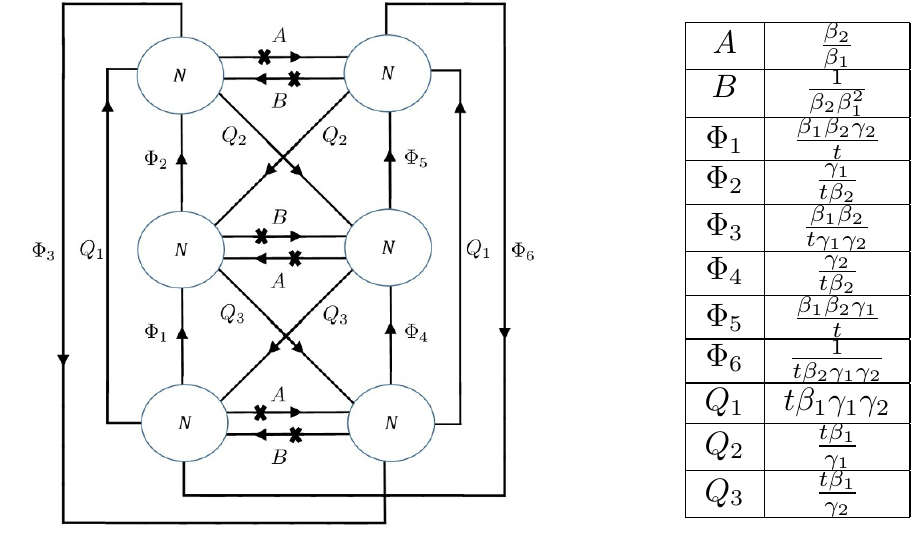
Figure 6 . On the left is the quiver diagram for the 4d class S 3 theory corresponding to a torus with only (cid:12) 1 (cid:13)ux, while on the right is a table summarizing the charges of the various (cid:12)elds. Note that several di(cid:11)erent (cid:12)elds have the same charges and so are represented with the same letter. This theory has a rather large cubic superpotential involving the 12 triangles in the diagram. Again these are most conveniently generated by taking all cubic terms consistent with the symmetries. Additionally there are the superpotential terms coming from the (cid:13)ipping, which in general are not cubic. It is again convenient to choose the R -symmetry so that all non-(cid:13)ipping (cid:12)elds have R -charge 2 3